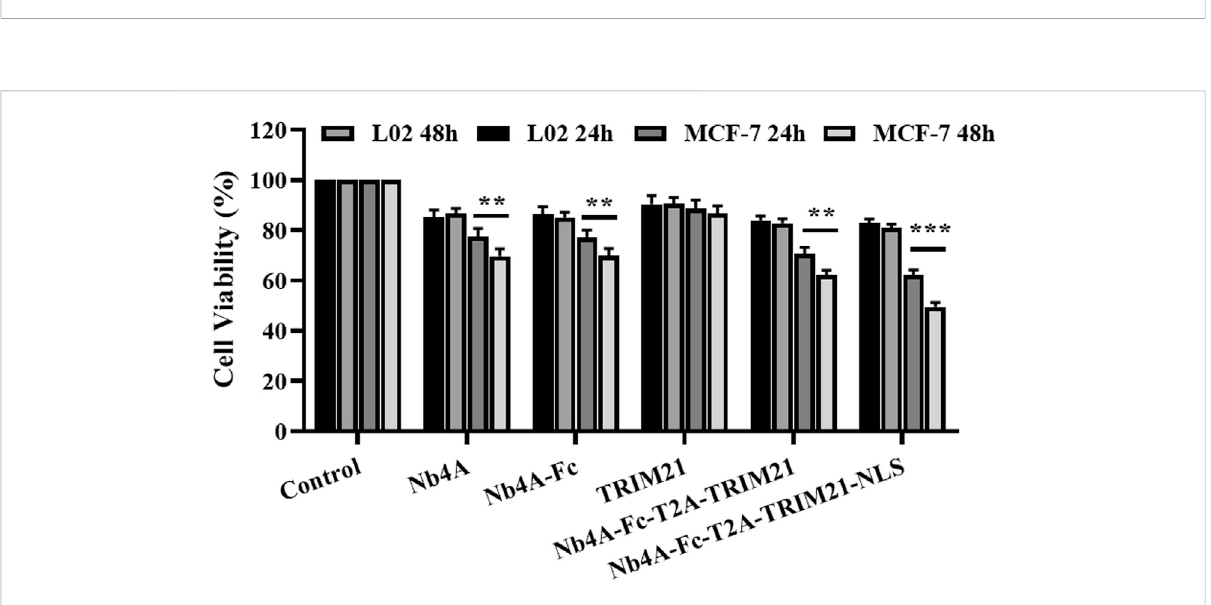
FIGURE 5 Effects of survivin degradation in different subcells on cell proliferation. The cell viabilities of MCF-7 and L-02 cells were measured by transfecting them with the recombinant plasmids pcDNA3.1(+), pcDNA3.1(+)-Nb4A, pcDNA3.1(+)-Nb4A-Fc, pcDNA3.1(+)-TRIM21, and pcDNA3.1(+)-Nb4A-Fc-T2A-TRIM21 and theplasmid pcDNA3.1(+)-Nb4A-Fc-NLS-T2A-TRIM21-NLS for 24 h and 48 h( n = 3). ** p < 0.01 and *** p < 0.001 versus control. Data are expressed as mean ±